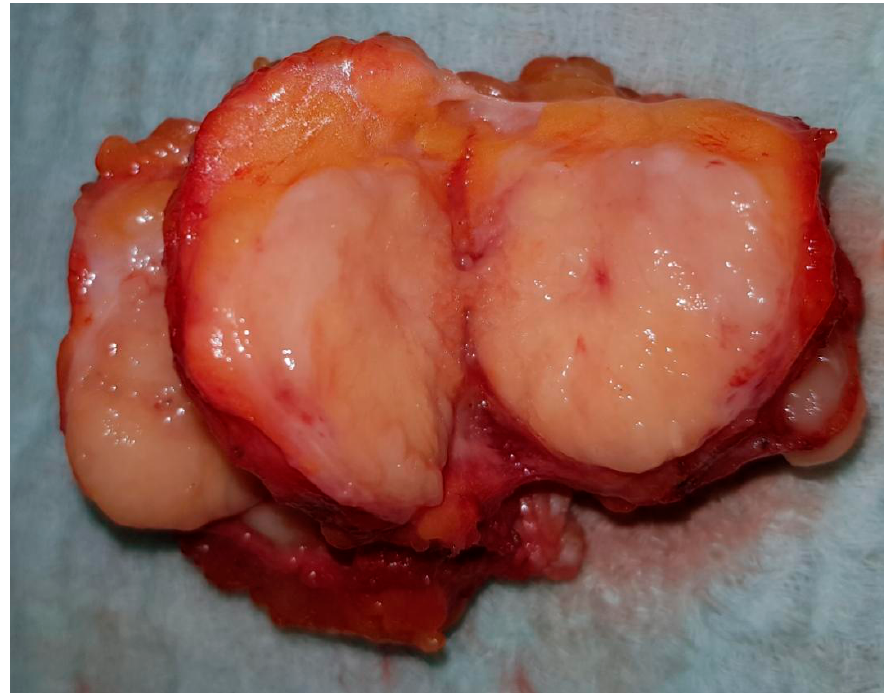
Figure 2. Gross specimen—non-encapsulated, circumscribed, nodular tumor. The fixed preparation was sent for histological examination, together with the complete documentation.